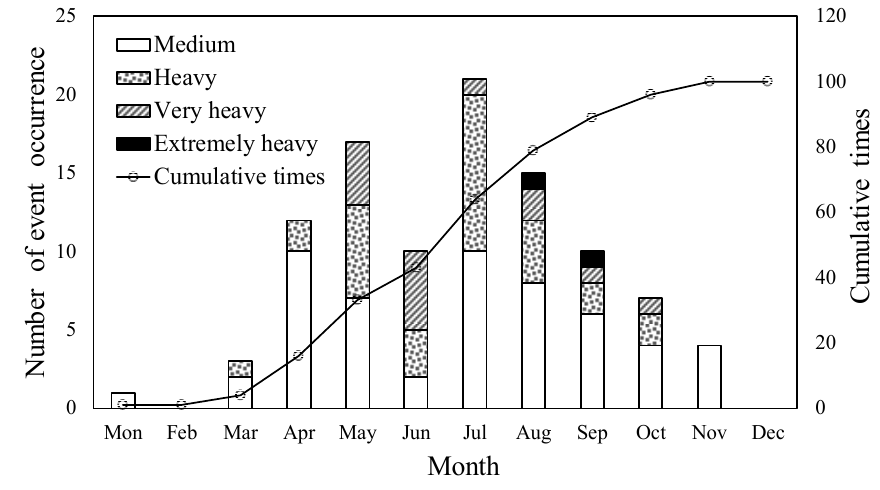
Figure 2. Monthly distribution of event occurrence of different types. Table 2. Characteristics of the selected rainfall-runoff